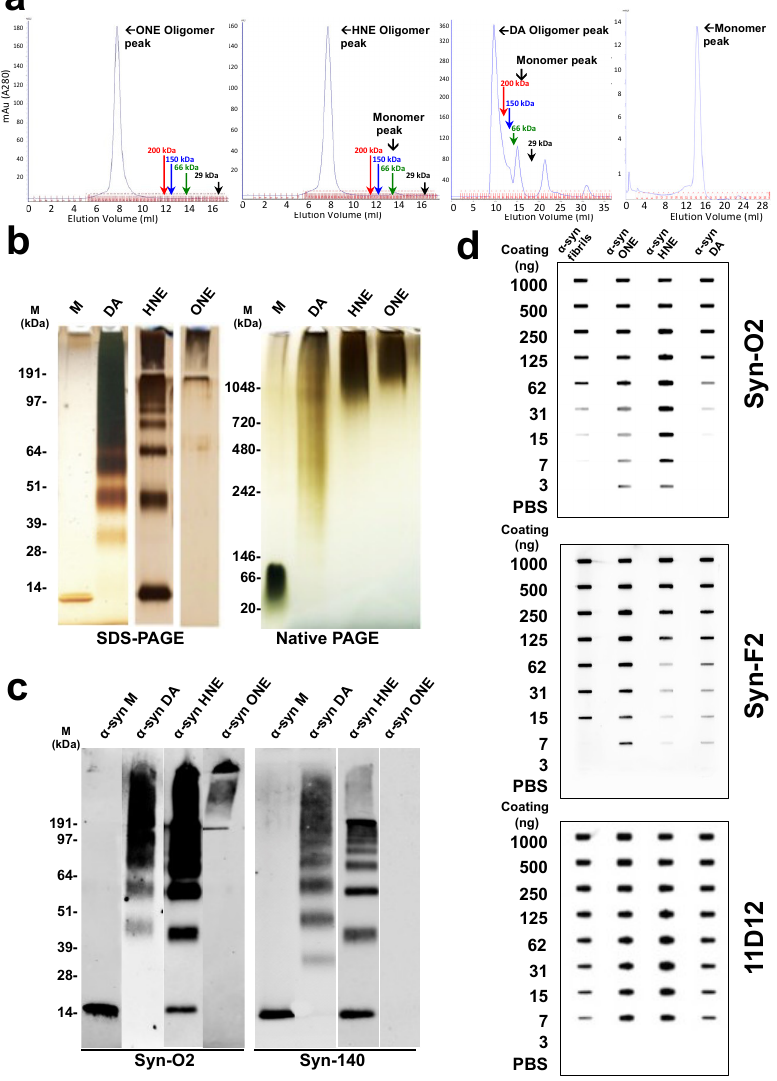
Figure 1. The purification and characterization of α -syn oligomers. ( a ) Purification of α -syn DA, HNE and ONE oligomers by SEC. α -Syn incubated in the presence of DA, HNE, or ONE was loaded onto a Superdex 200 (10/300) column and eluted at a flow rate of 0.5 mL/min in PBS and elution monitored at 280 nm. The elution profile of the standards Dextran blue (2000 kDa); β -amylase (200 kDa); alcohol dehydrogenase (150 kDa); albumin, bovine serum (66 kDa) and carbonic anhydrase (29 kDa) are indicated by an arrow. ( b ) Silver staining under denaturing SDS-PAGE (left) and non-denaturing Native PAGE (right). Two micrograms of α -syn monomers or oligomers were loaded onto the gel and silver-stained. ( c ) Western blot analysis of the oligomers under denaturing conditions. 50 ng of α -syn monomers or oligomers was loaded onto SDS-PAGE gel, transferred to a nitrocellulose membrane, and probed with mouse anti- α -syn monoclonal antibody, Syn-O2 or polyclonal sheep antibody, Syn-140. ( d ) Slot blot results showing the reactivity of conformational antibodies Syn-O2 or Syn-F2 and generic antibody 11D12 to different quantities of α -syn fibrils and α -syn ONE, HNE, or DA